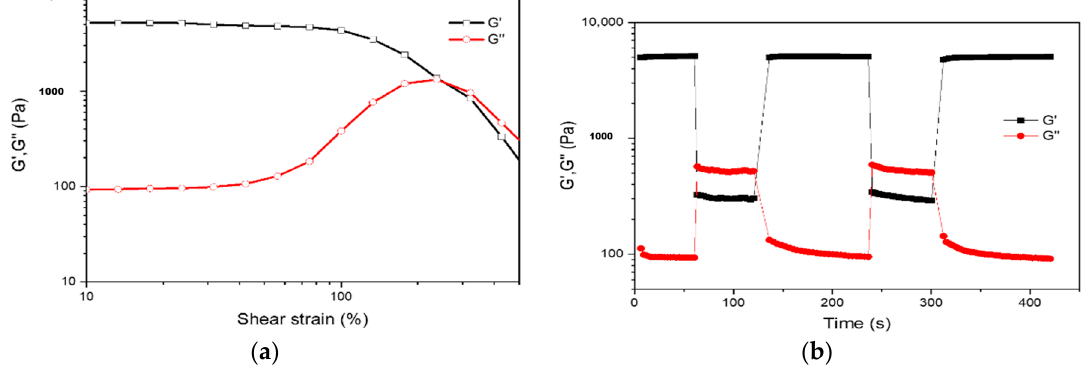
Figure 5. ( a ) Strain amplitude sweep measurements from 10% to 500% strain of CMC-OSA-DTP hydrogels. ( b ) Continuous step-strain measurements at alternate 0.1% and 500% strain of CMC-OSA-DTP hydrogels.